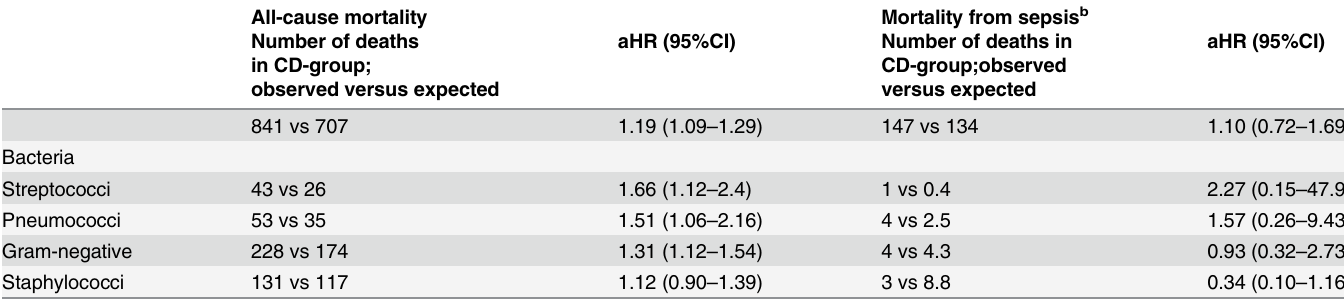
Table 3. Mortality overall and according to bacterial origin a of